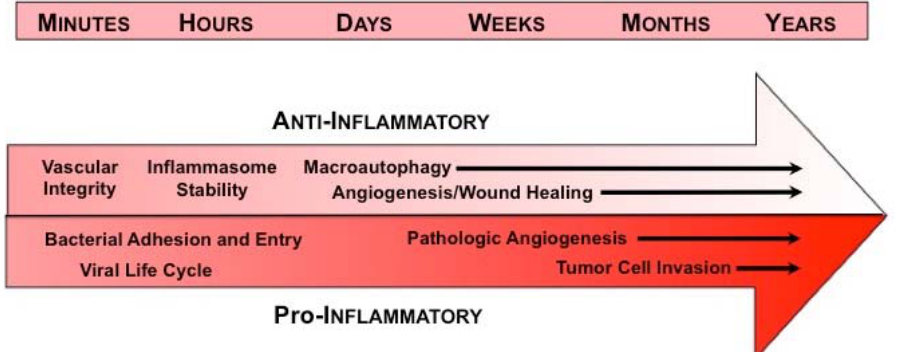
Figure 1. Annexin A2 in inflammatory responses—working model. Under homeostatic conditions (top arrow), AnxA2 plays an anti-inflammatory role in response to injury or infection. In the immediate response to injury, AnxA2 maintains vascular integrity, thereby preventing edema and extravasation of blood cells. Within minutes to hours, AnxA2 also protects internal membranes, such as those delimiting the lysosome, thus preventing inflammasome activation and tempering cytokine production. AnxA2 is also necessary for biogenesis of the phagophore, a double membrane structure that engulfs and destroys intracellular pathogens and allows the cell to adapt to environmental stresses in the process of macroautophagy. In the later stages of inflammation, AnxA2 likely promotes angiogenesis and wound healing by supporting cell surface fibrinolytic activity. In disease states, however (bottom arrow), AnxA2 may be co-opted to perform pro-inflammatory actions. On the plasma membrane, AnxA2 appears to serve as a site for bacterial adhesion and entry into cells, and may enable viral infection, replication, and release. In chronic inflammatory states, excessive angiogenesis that is sustained by AnxA2 may induce tissue damage, as in the diabetic retina, or may support the progression of cancer. In addition, some tumor cells may utilize cell surface AnxA2 to generate protease activity necessary for migration and metastasis within a pro-inflammatory micromilieu.